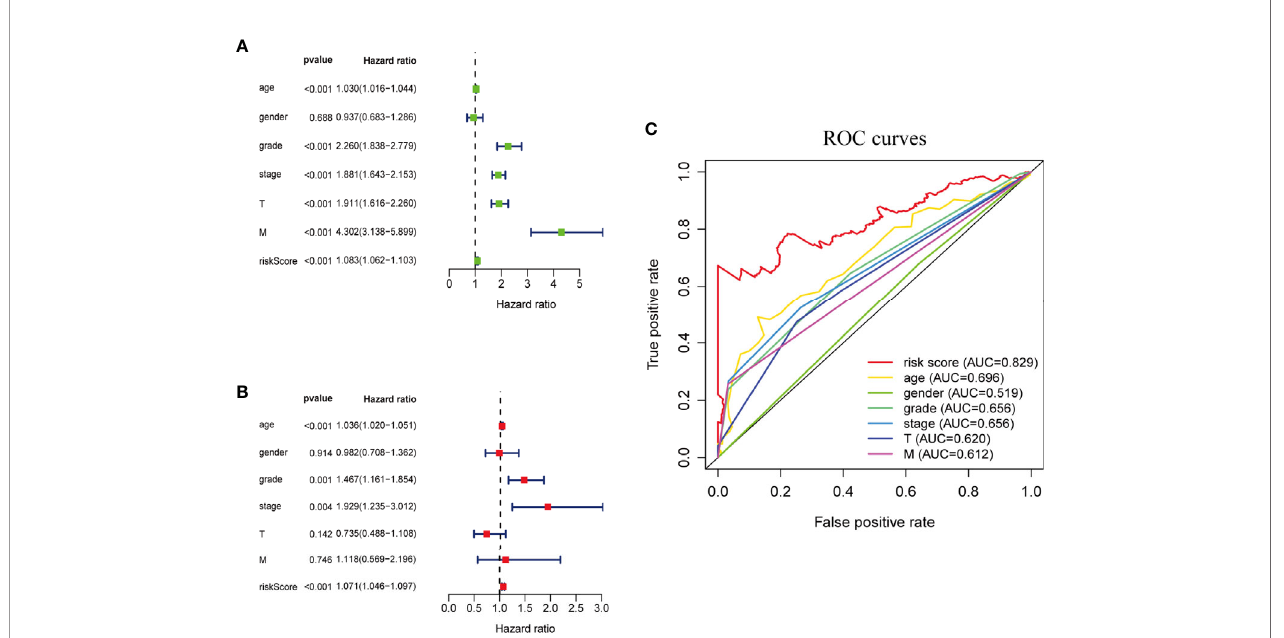
FIGURE 3 | Ferroptosis-related genes prognostic signatures and other clinicopathological variables were used to evaluate the prognostic accuracy of ccRCC patients. (A) Univariate Cox regression analysis showed the correlation between overall survival rate and various clinicopathological parameters (Age, Gender, Grade, Stage, T and M stage). (B) Multivariate Cox regression analysis showed that age, grade, stage and risk score were independent prognostic indicators for overall survival of ccRCC patients. (C) ROC curve analysis showed the prognostic accuracy of risk score and clinicopathological parameters.